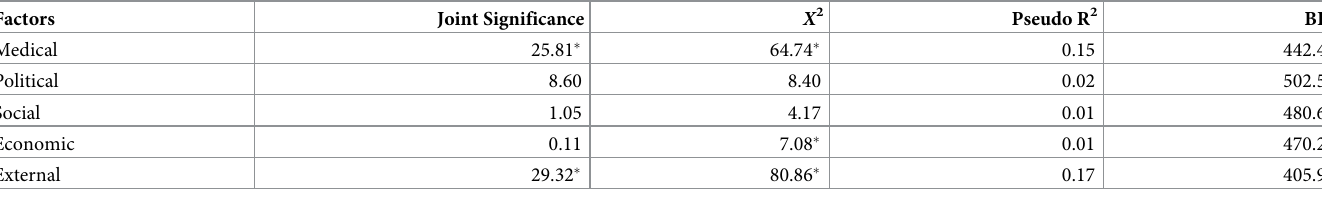
Table 5. Relative effects of the broad